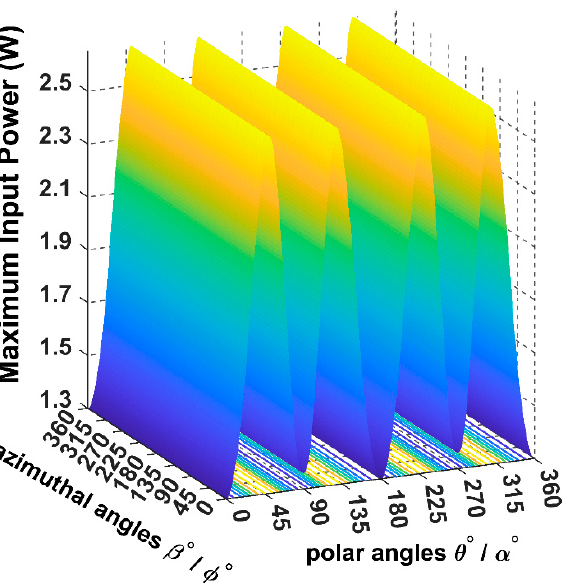
Figure 19. Maximum input power variation when the receiver angles and the magnetic angles are changed equally for the proposed trajectory.